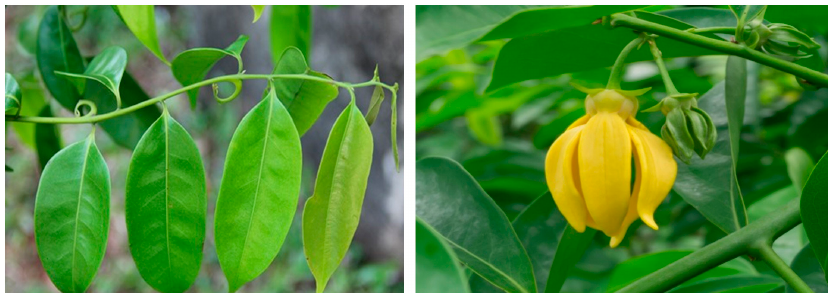
Fig. 1. Artabotrys suaveolens is a scrambling or climbing, evergreen